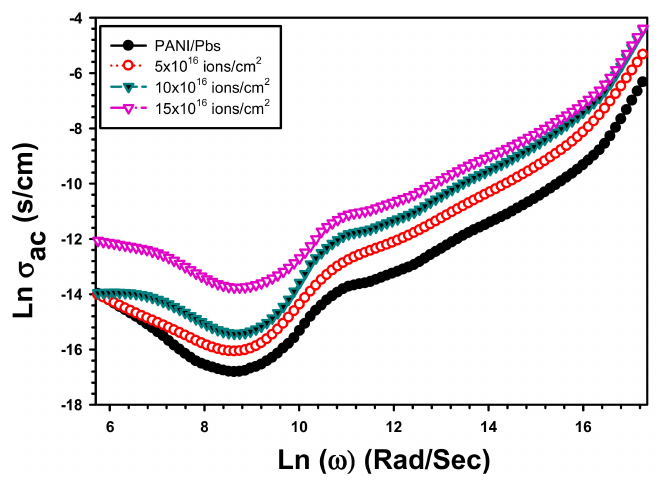
Figure 13. Conductivity σ ac against Ln ( ω ) for pristine and treated PANI/PbS.